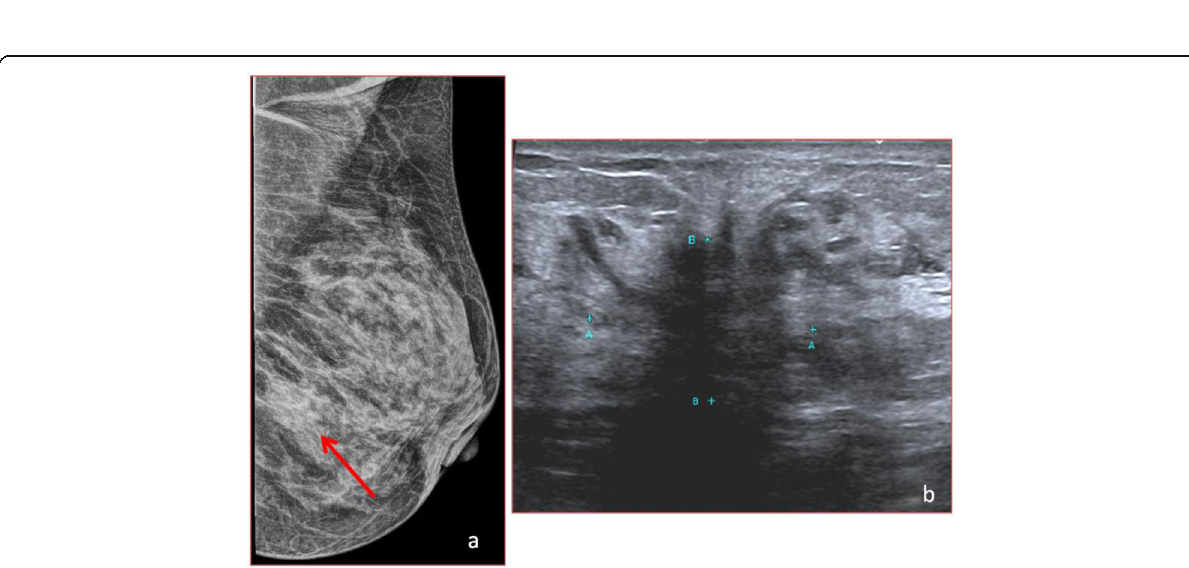
Fig. 4 A 31-year-old female diagnosed with idiopathic granulomatous mastitis, who presented with complaints of pus discharge from sinus tract in the left subareolar region with associated pain. a Clinical picture showing external sinus tracts with redness in the surrounding breast. b Extended view on high resolution ultrasound showing multiple collections (green arrow), surrounding heterogenous parenchyma (black arrow) & skin thickenning (red arrow head)